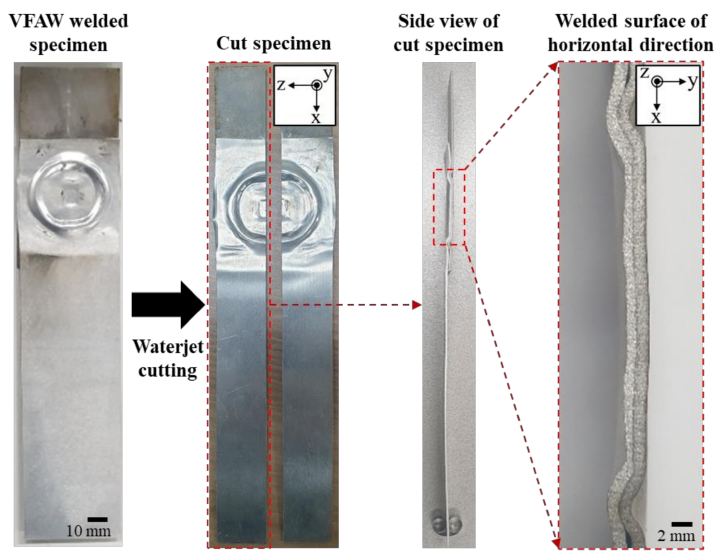
Figure 13. Preparation of the welded specimen from the VFAW test for thickness measurement.